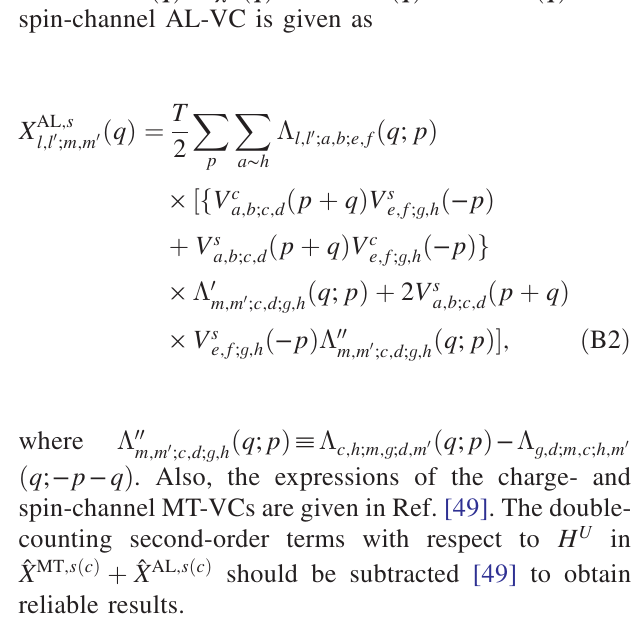
calculation.FIG. 6. Band structure of (a) LaFeAsO and (b) FeSe in the experimental orthorhombic crystal structures obtained by the WIEN 2k